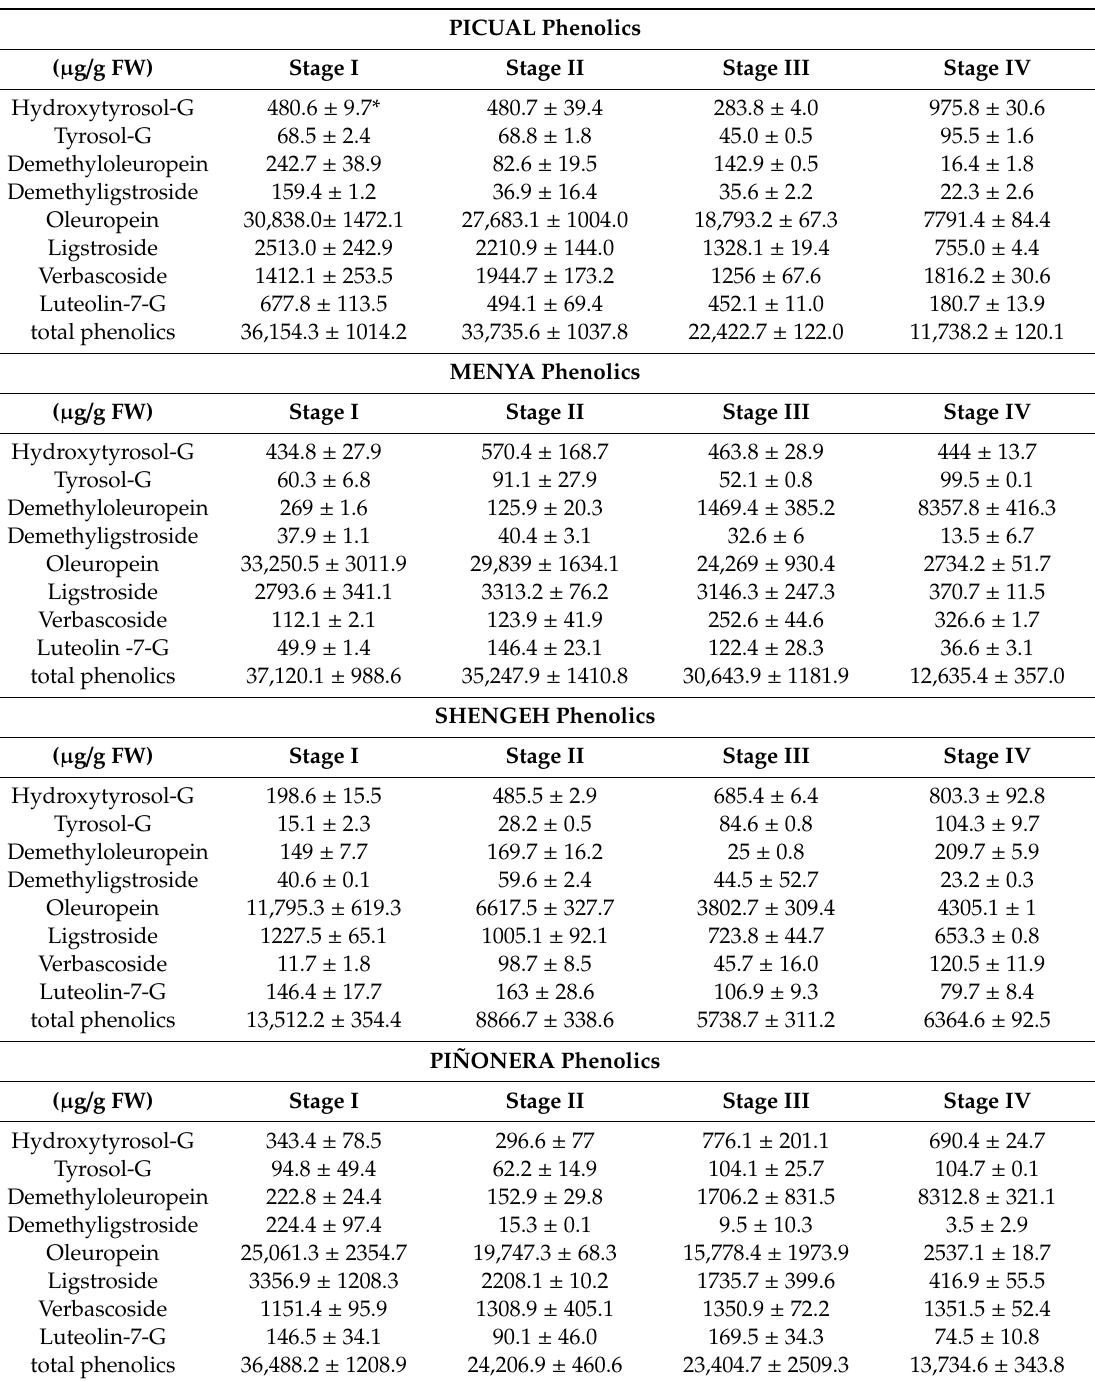
Table 1. Concentration of phenolic compounds, µ g / g fresh weight (FW), in olive fruits from Picual, Menya, Shengeh, and Piñonera cultivars harvested at di ff erent ripening